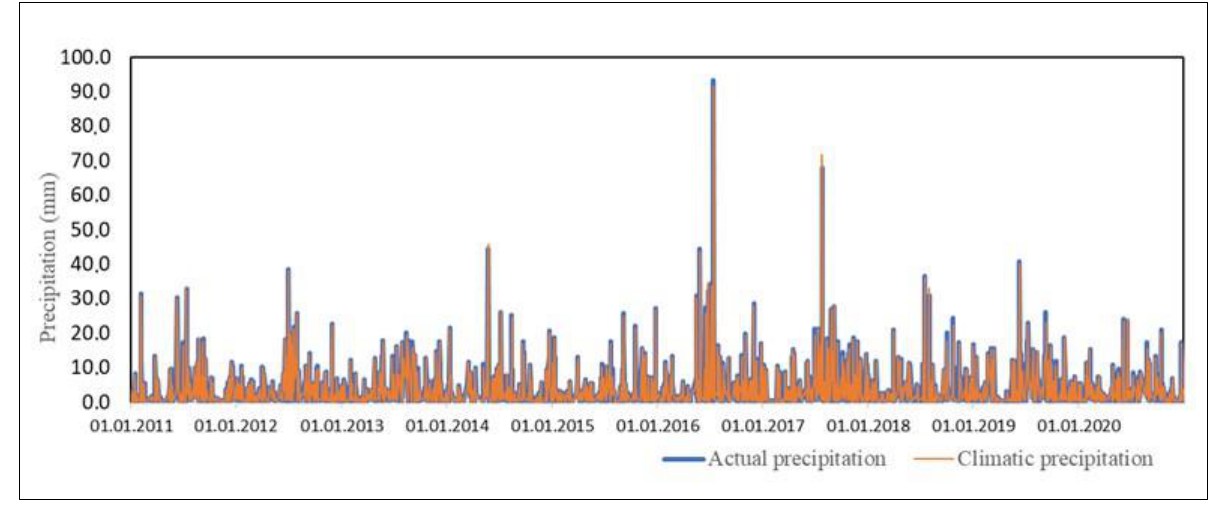
Figure 7. Distribution of the actual precipitation and climatic precipitation in the period from 2011 to